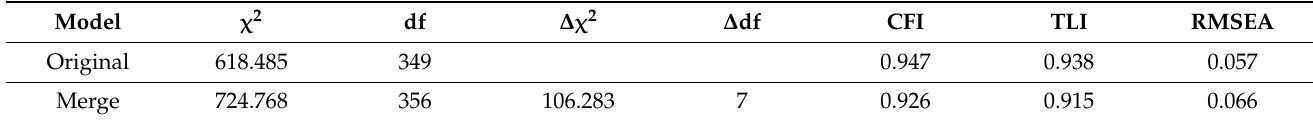
Table 5. Discriminative validity reasoning based on Bagozzi and Yi.